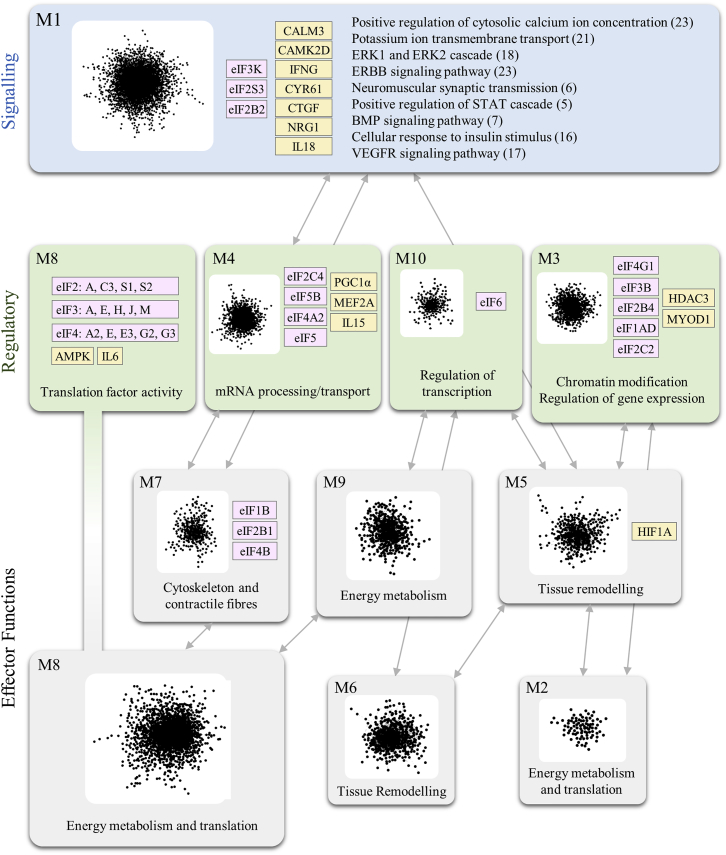
Effects of Endurance Training on Gene Co-expression in Skeletal MuscleThis network represents the 10 largest gene modules identified by the gene co-expression analysis (module size is proportional to the number of genes). Genes within each module showed highly significant alteration in gene-gene pairwise correlation between trained and untrained states (FDR < 1%). Modules connected by arrows showed significant inter-module alterations in correlation between trained and untrained states (FDR < 10%). Each module has been annotated with genes known to play a key role in muscle biology (gold) and in the eukaryotic initiation factors (pink) found within that module. M1 is labeled with enriched gene ontology terms reflecting signaling pathways. Every other module has been summarized using a functional term representative of the enriched gene ontology terms.